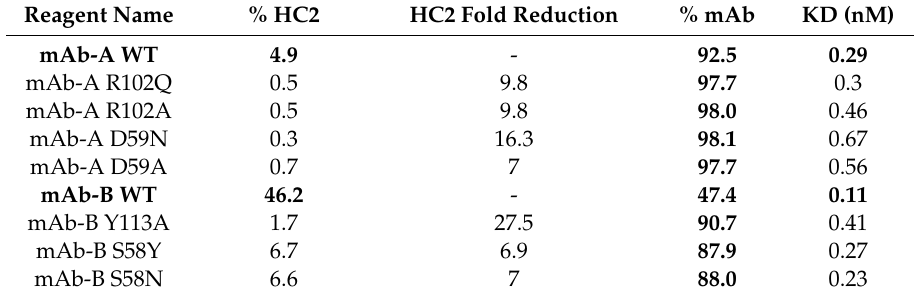
Table 6. For mAb HC / LC cotransfection, e ff ect of HC2 formation for both mAb-A and mAb-B is evaluated for each mutant predicted to reduce HC dimer propensity by the Fd2-A crystal structure. % mAb form and % HC2 quantified by NR-cSDS are tabulated along with fold reduction compared to the wild-type version. Lastly, BIAcore a ffi nities of the mAb (KD) towards recombinant target antigen as the analyte are